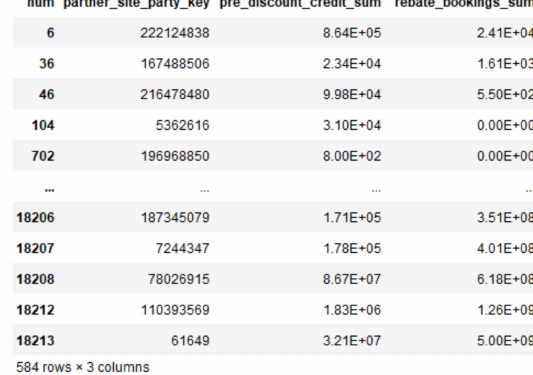
Figure 10. Abnormal behaviors